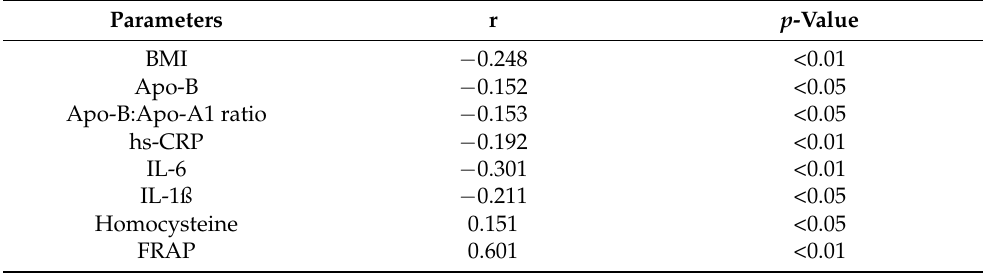
Table 4. Correlations between UCB and oxidative stress related marker in the total study group.